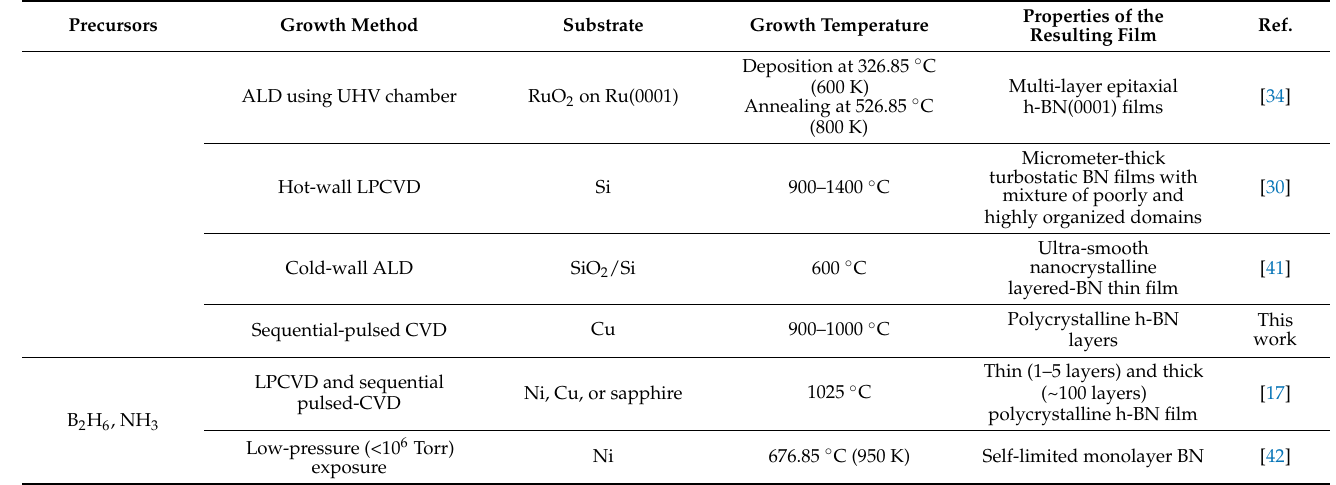
Figure A2. HR-TEM images of h-BN films with accidentally folded regions, captured from different spots. The film was grown at 1000 °C for 15 cycles. Approximate numbers of layers are ( a ) 4 layers, ( b ) 5 layers, and ( c ) 5 layers. Scale bar: 2 nm. References 1.